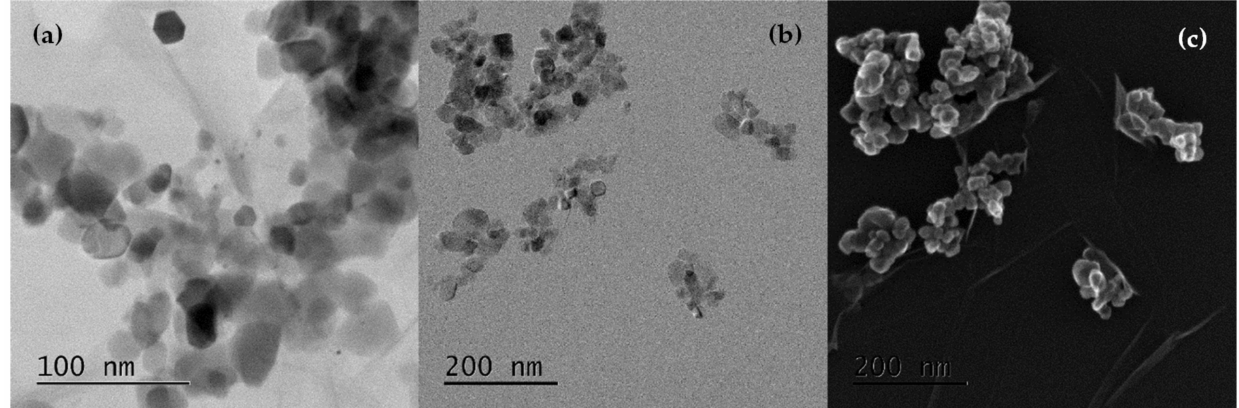
Figure 1. ( a , b ) TEM images of Cu(2%)-TiO 2 -trGO300; ( c ) SEM image of Cu(2%)-TiO 2